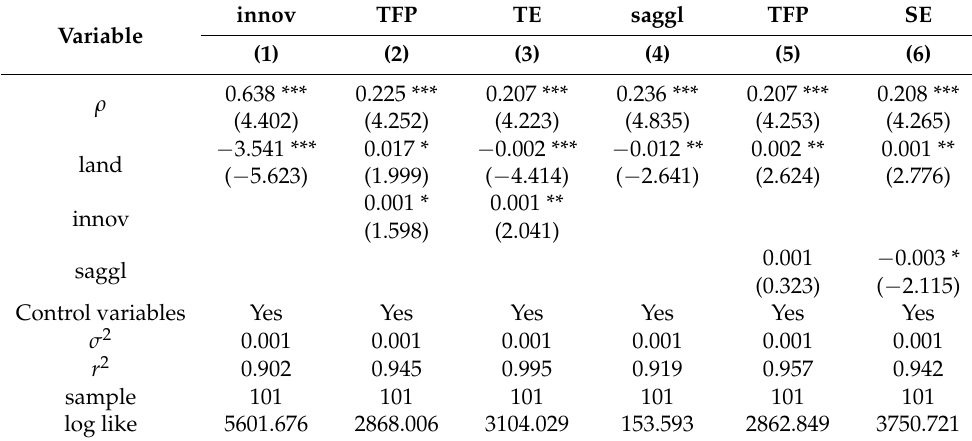
Table 7. Test of influence mechanism in the east